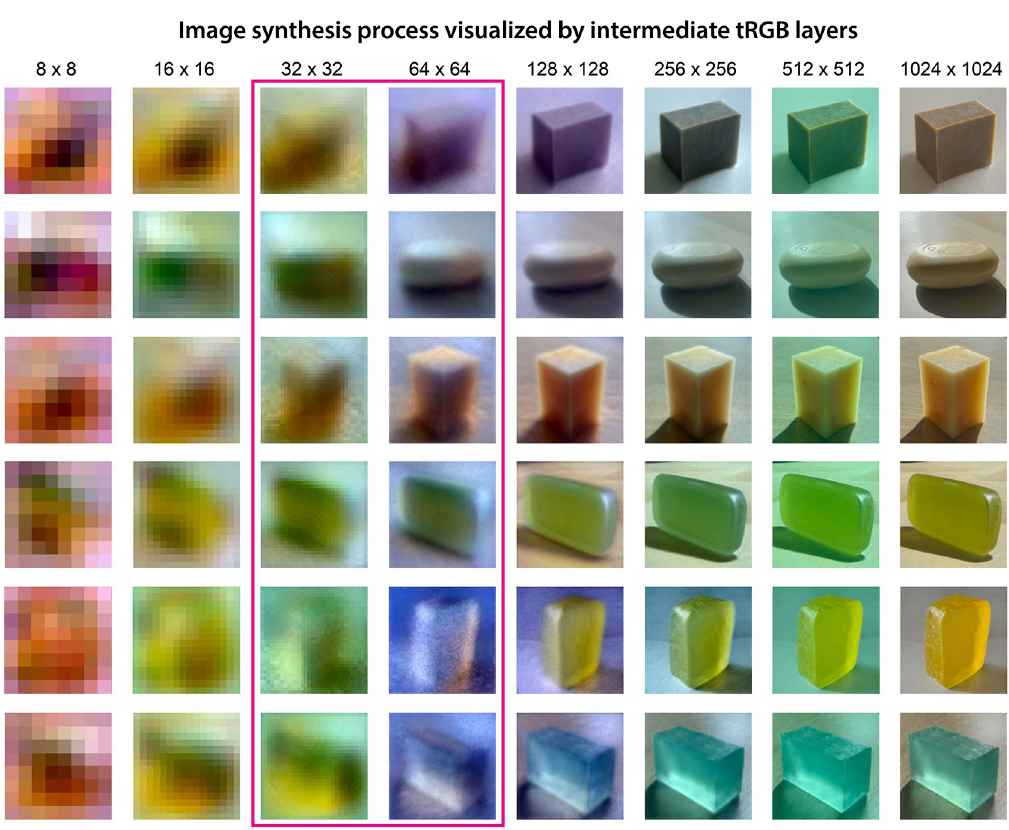
Fig 6. Visualization of the generative process of the network. Impression of translucency emerges at the early stages of the image synthesis process while more details of the appearance are added in the later stages. Each row corresponds to the intermediate generative outputs from a sequence of tRGB layers at different spatial resolutions in StyleGAN2-ADA’s generative network. Translucency-related features are established as early as 32 pixels × 32 pixels (layers 7 and 8) and 64 pixels × 64 pixels (layer 9). The surface reflective properties such as specular highlights are only clearly visible at 128 pixels × 128 pixels (layers 11 to 12). The body color of the soap was finalized at the resolution of 1024 pixels × 1024 pixels (layers 17 to